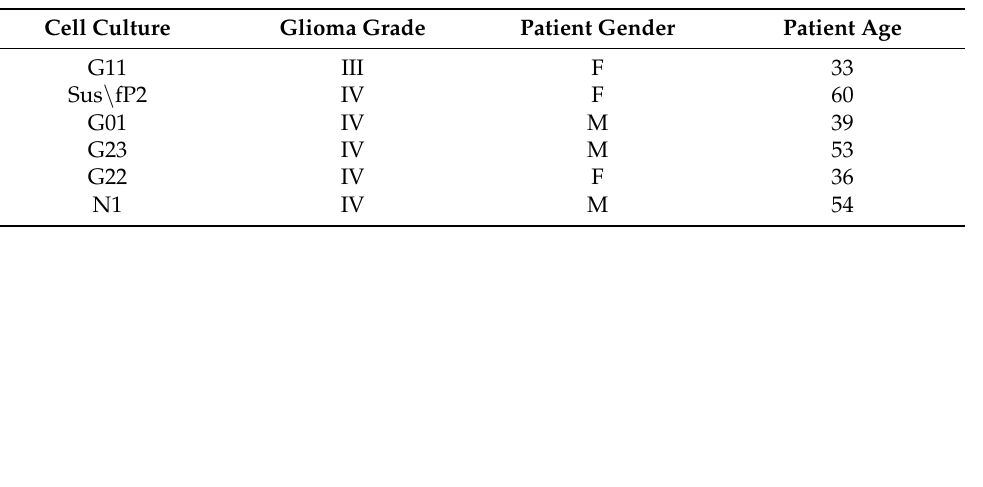
Table 1. List of patient glioma primary cell cultures, and brief data on patients. All samples have